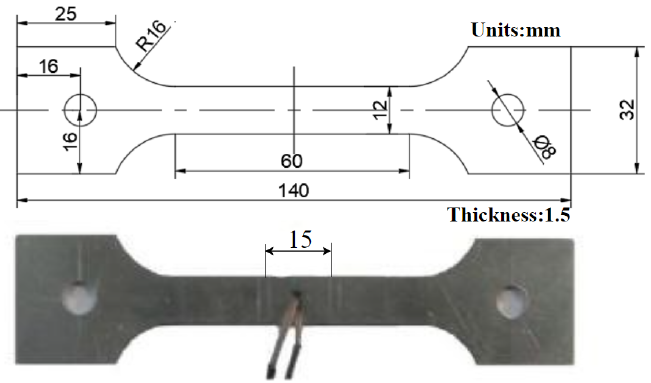
Figure 1. The shape and size of the sample. During the test, a thermocouple is welded to the middle surface of the specimen to test the temperature of the specimen. The heating time and cooling rate are controlled, and a 15-mm scale (15 mm for the mean temperature section) is set by scribing to correct the stress–strain curve and to obtain the true stress–strain curve by calculation. The test process is carried out on the Gleeble-3500, manufactured by FULETE Instrument Technology (Shanghai) Company Limited (Shanghai, China). To make the experimental results accurately reflect the mechanical behavior of 6016 aluminum alloy during hot stamping, a high-temperature tensile experimental program for 6016 aluminum alloy was developed according to the range of the deformation tem- perature and strain rate of the hot stamping process; the temperature and the deformation experienced by the aluminum alloy specimen during the experiment is shown in Figure